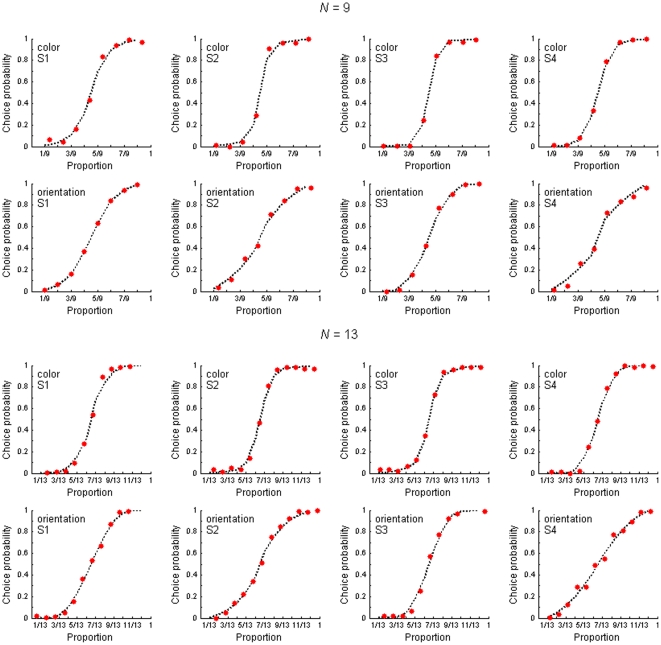
The best fitting theoretical models (dotted line) vs empirical results (red points).The choice probability as a function of the proportion of the chosen response category for four observers, two discrimination tasks (color and orientation), and two numbers of elements (N = 9 and 13). Each point is a probability estimate computed from 100 trials. The dotted line represents the best fitting theoretical mixture model shown in Tables 1.A and 2.A.